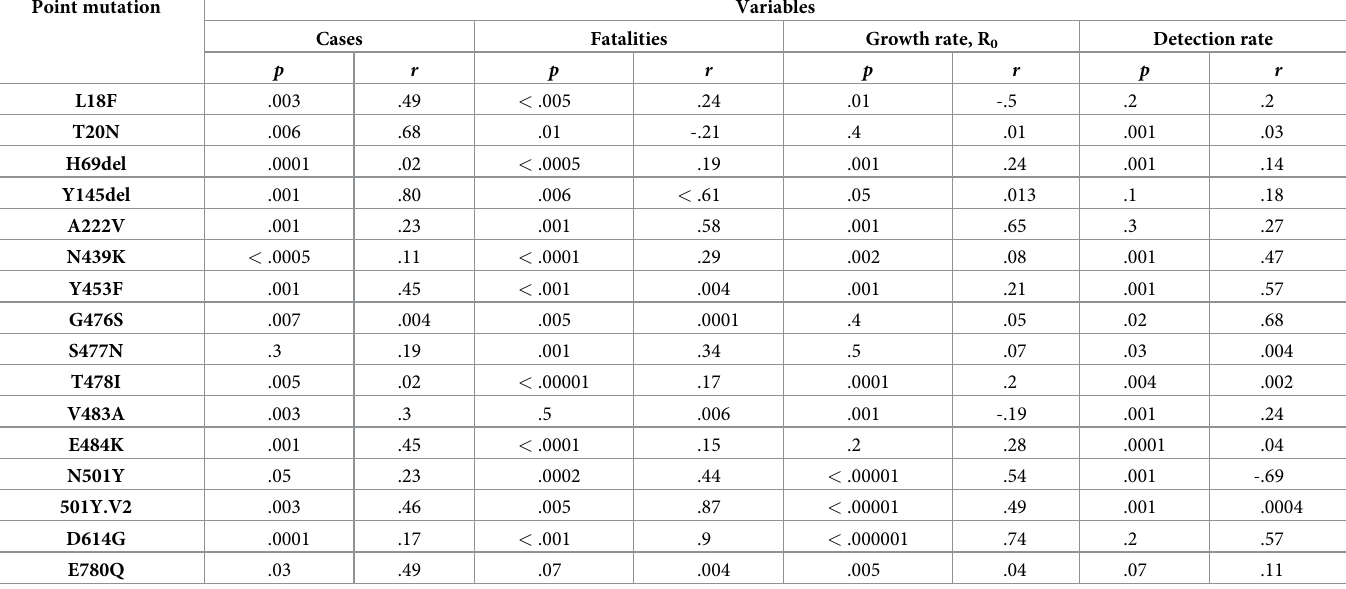
Table 2. Pearson correlation coefficient between specific mutations of SARS-CoV-2 spike protein and COVID-19 cases, fatalities, transmission rate (R 0 ), and detec- tion rate. Point mutation